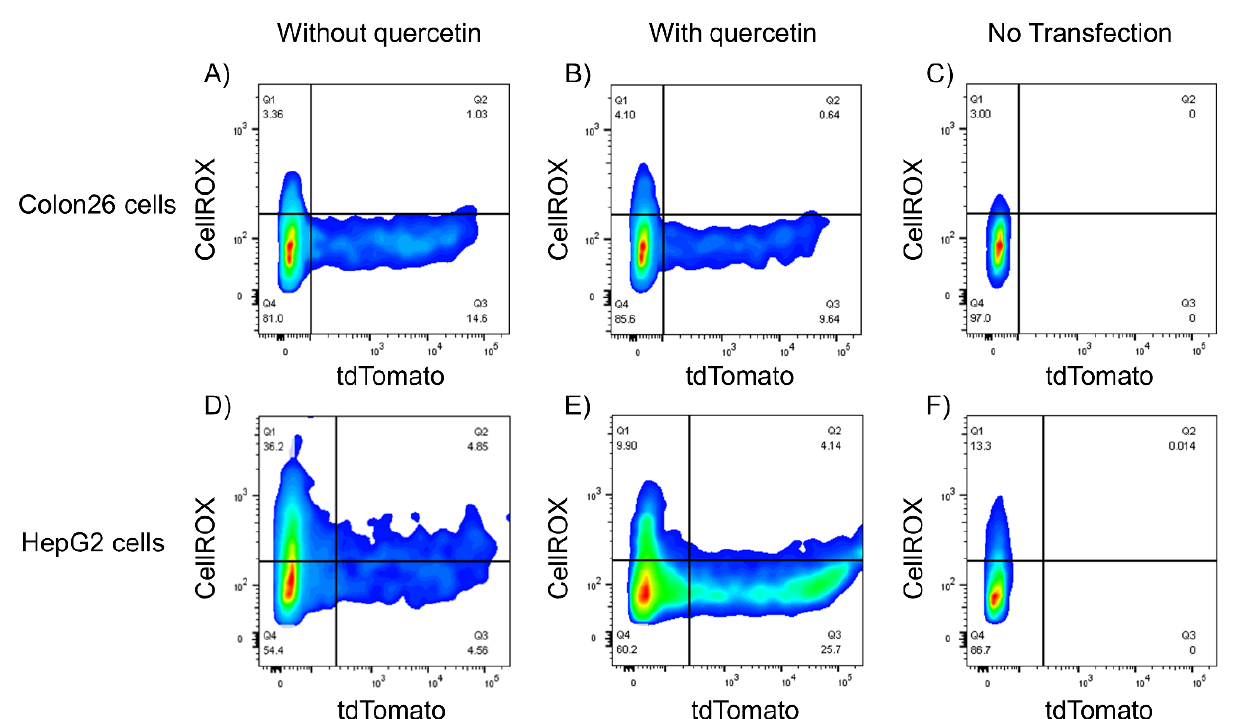
Figure 7. Relationship between gene expression and cellular reactive oxygen species (ROS) levels analyzed by flow cytometry. ptdTomato-C1 (1 µg/well) was complexed with Lipofectamine 3000 without ( A , D ) and with quercetin (25 µM) ( B , E ) transfected with lipoplexes, and cells without lipoplexes to detect basal ROS levels ( C , F ) in 2D Colon26 ( A – C ) and HepG2 ( D – F ) cells,